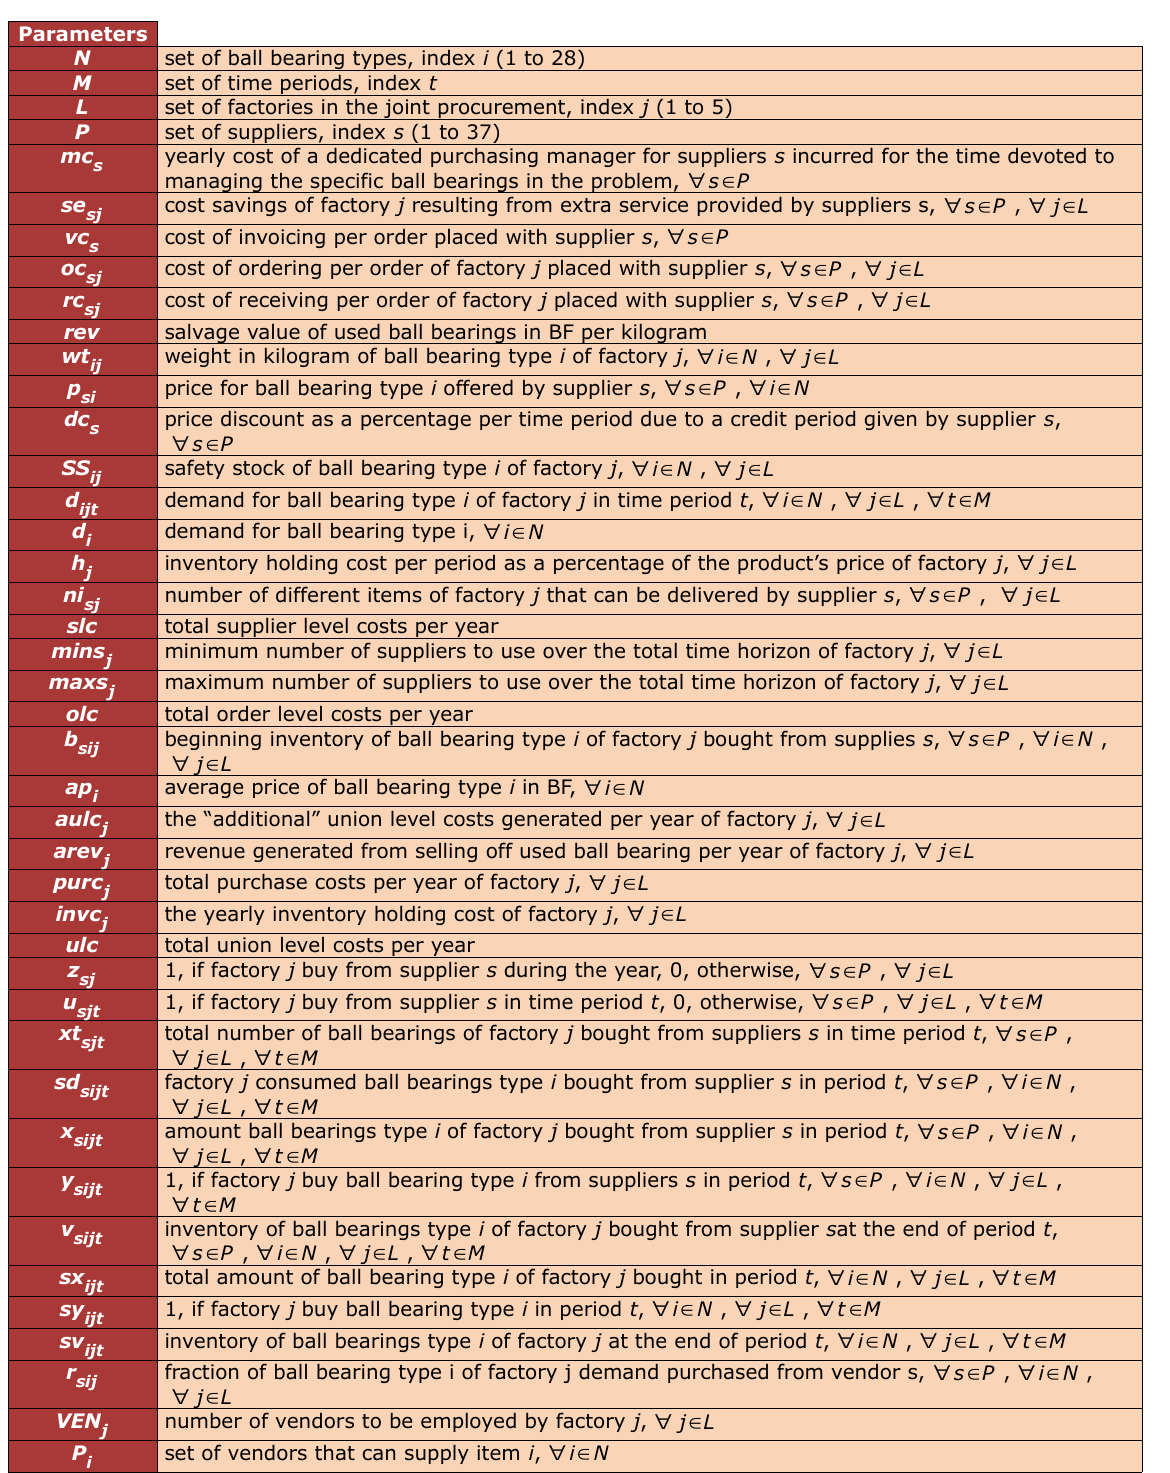
Table 2. Symbols of the